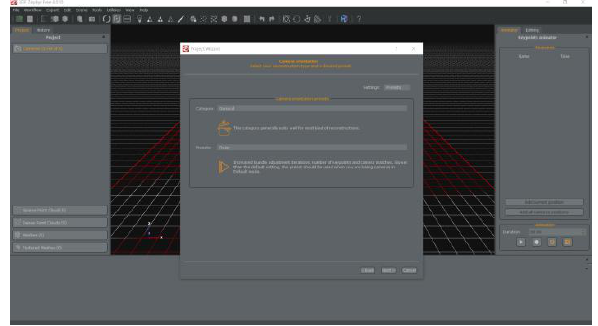
Figure 5 . The Requirements of Software